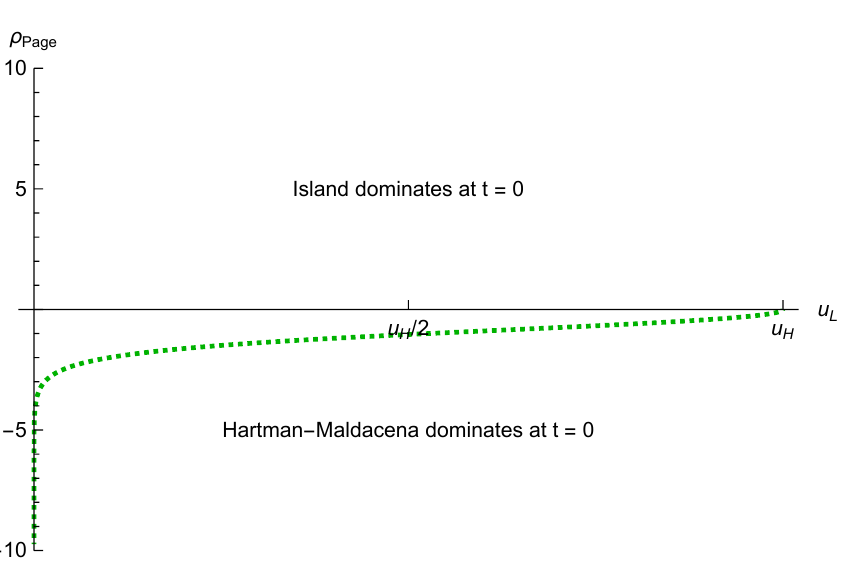
Figure 10 . A plot of the Page angle ρ Page in the special case u R = u H . Note that the horizontal 2 axis here now refers to the location of u L . This plot is equivalent to plotting the density along a horizontal slice of figure 8 at u R = u H 2